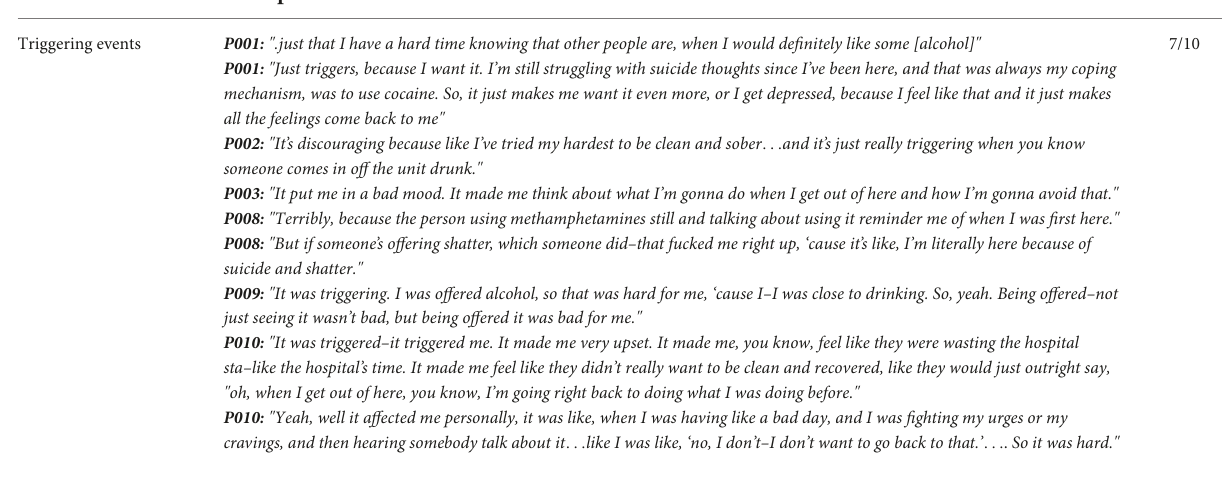
TABLE 3 Direct quotes about how participants responded to contraband substances at the hospital. Theme